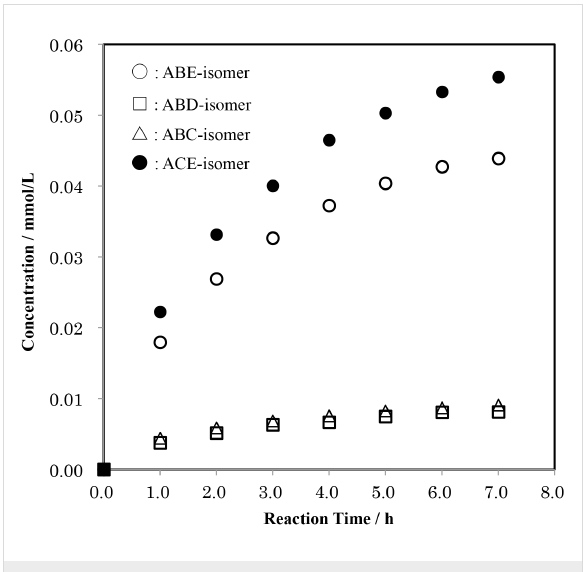
Figure 8: Time-course of the formation of the regioisomers of tri-6- O - trityl- α -CD in a reaction of AC-isomer with TrCl in pyridine at 55 °C. Average mole ratio of ABC:ABD:ABE:ACE = 0.17 ± 0.01:0.15 ± 0.01:0.80 ±